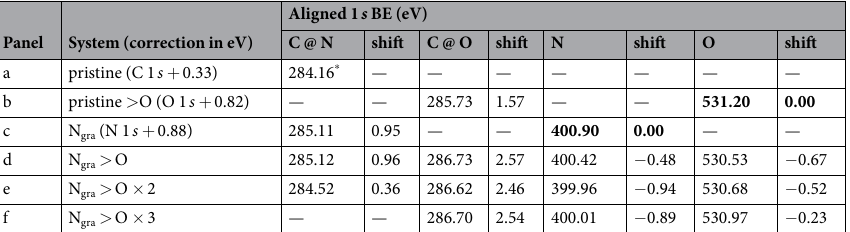
Table 2. Calculated 1 s core level binding energies (BEs). For ease of interpretation, the energies for each element are corrected by a constant factor so that the bolded values (pristine graphene, graphitic N, epoxide O; magnitude of correction denoted below system identifier) match experimental values. * For pristine graphene, this value refers to the bulk C 1 s